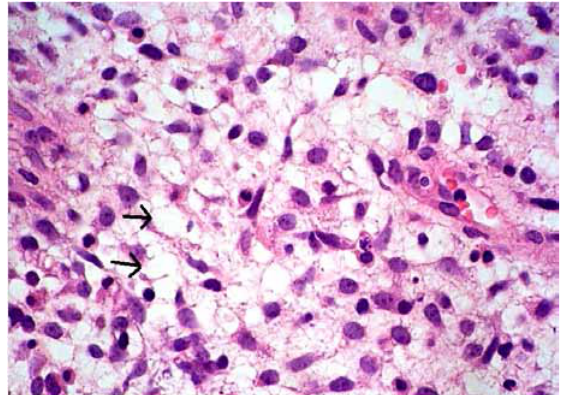
Figure 2. Histopathological exam (Haematoxylin Phosphotungstic stain, ob.40x); the electron microscopic appearence of the embryonal type of rhabdomyosarcoma with cytoplasmic microfibrils (arrow).